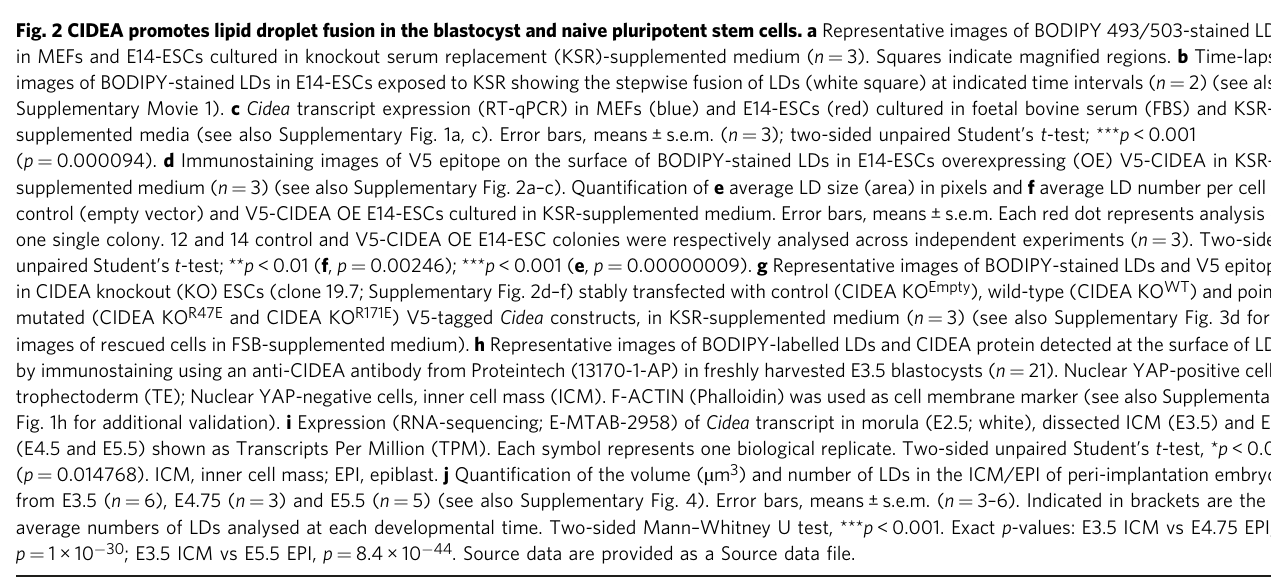
Fig. 2 CIDEA promotes lipid droplet fusion in the blastocyst and naive pluripotent stem cells. a Representative images of BODIPY 493/503-stained LDs in MEFs and E14-ESCs cultured in knockout serum replacement (KSR)-supplemented medium ( n = 3). Squares indicate magni fi ed regions. b Time-lapse images of BODIPY-stained LDs in E14-ESCs exposed to KSR showing the stepwise fusion of LDs (white square) at indicated time intervals ( n = 2) (see also Supplementary Movie 1). c Cidea transcript expression (RT-qPCR) in MEFs (blue) and E14-ESCs (red) cultured in foetal bovine serum (FBS) and